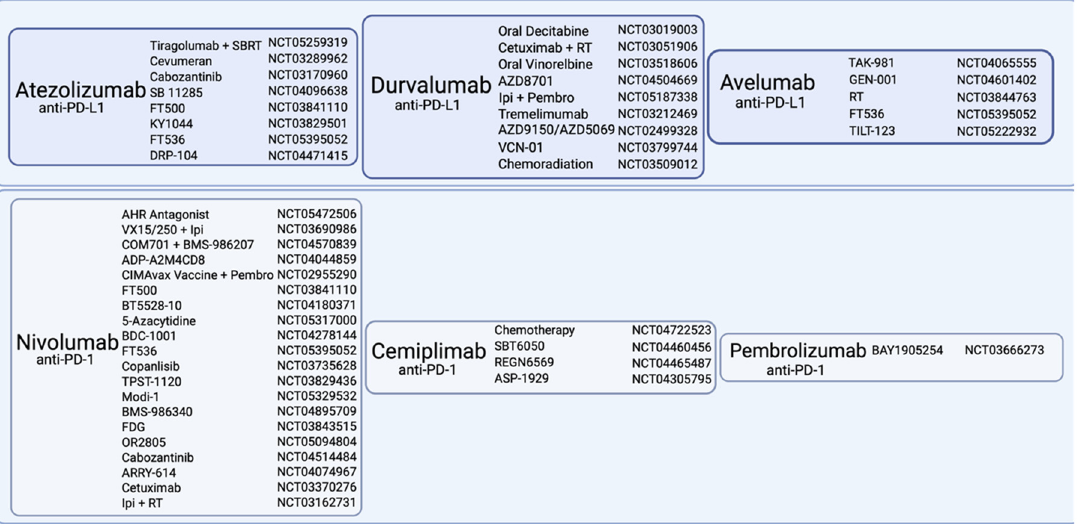
Figure 3. List of early-phase studies of common clinically used ICIs in combination with various therapeutics and radiation modes (created with Biorender.com).